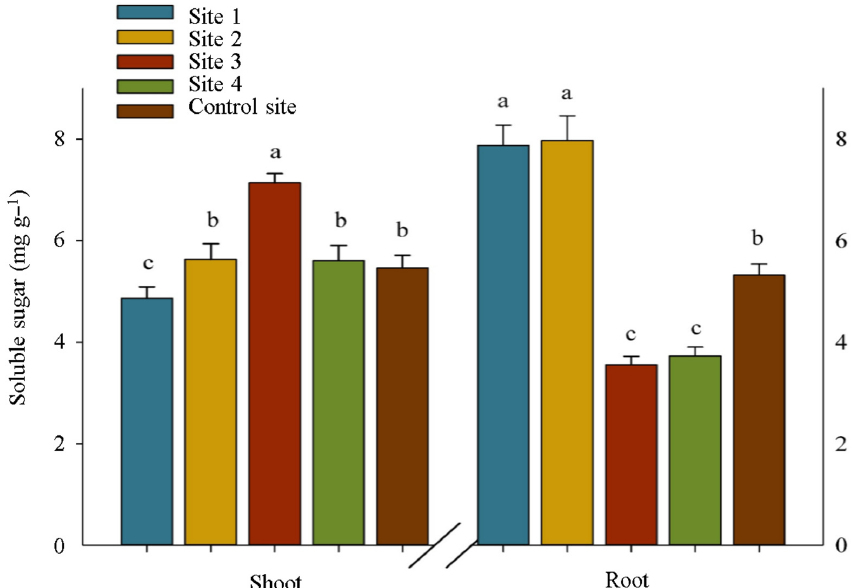
Figure 4. Soluble sugar content in the shoot and root of S. portulacastrum plants at different levels of heavy metals pollution. Means in each tissue followed by similar letter(s) are not significantly different at 5% probability level (Tukey’s HSD test).